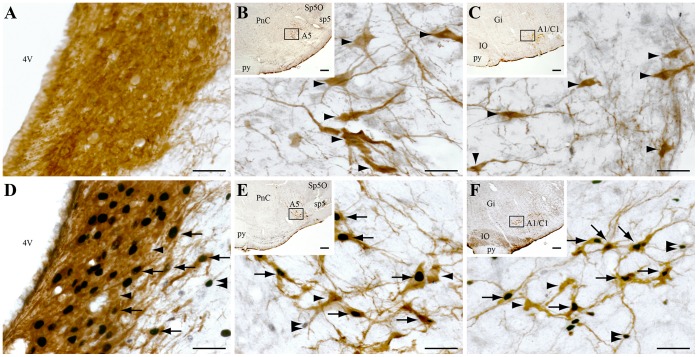
Noradrenergic and adrenergic neurons strongly express c-FOS after muscimol inhibition of the DPGi.Double-immunostained sections with TH (brown cytoplasmic staining) and c-FOS (black nuclear staining) at the level of A6 (A,D), A5 (B,E) and A1/C1 (C,F) noradrenergic cell groups after NaCl (top panel) or muscimol (bottom panel) injection in the DPGi. Black arrows point out double labeled neurons whereas black arrowheads and double arrowheads indicate TH singly and c-FOS singly labeled neurons, respectively. Scale bars, 50 µm for low power and 200 µm for high power photomicrographs in B, C, E and F. Abbreviations: 4V, 4th ventricle; A1/C1, A1 noradrenergic and C1 adrenergic groups; A5, A5 noradrenergic group; Gi, gigantocellular reticular nucleus; IO, inferior olive; PnC, pontine reticular nucleus, caudal part; py, pyramidal tract; sp5, spinal trigeminal tract; Sp5O, spinal trigeminal nucleus, oral part.